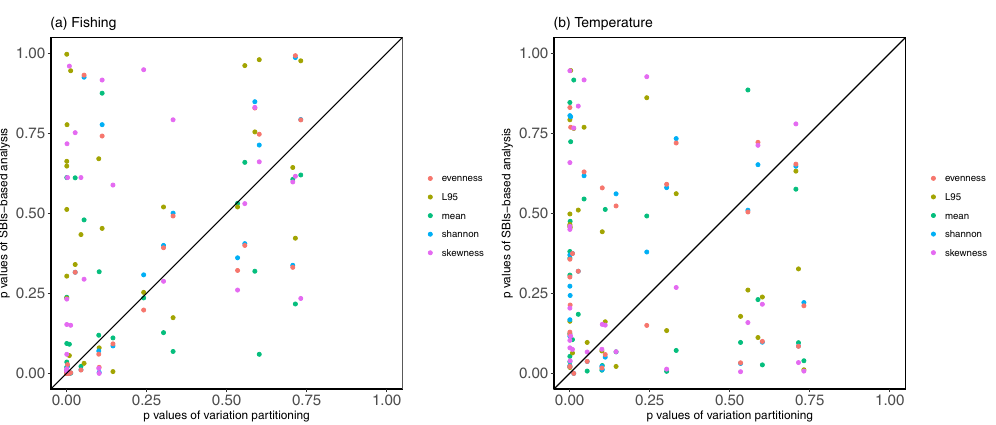
Figure 4. Comparison of P values of ( a ) fishing and ( b ) temperature effect estimated from the variation partitioning approach versus univariate SBIs. The diagonal line represents the 1:1 line. Results of binomial test indicate that variation partitioning is more efficient in rejecting the null hypothesis (p-value is smaller) than the univariate SBIs in detecting temperature effects (Probability of success = 0.63, P = 0.003) and marginally in fishing effects (Probability of success = 0.56, P =